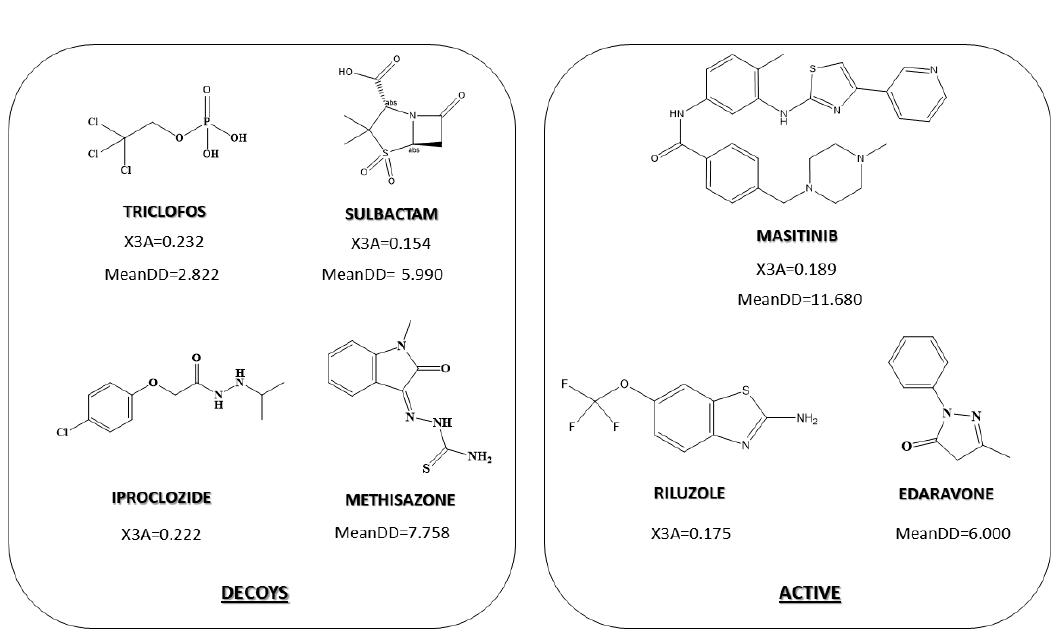
Figure 1. The most relevant descriptors in determining the chemical–mathematical pattern related to anti-ALS activity for DF gen .